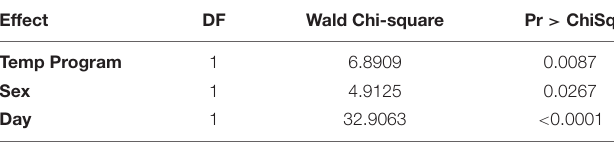
TABLE 4 | Analysis of maximum likelihood estimates for blueberry detectability over time.